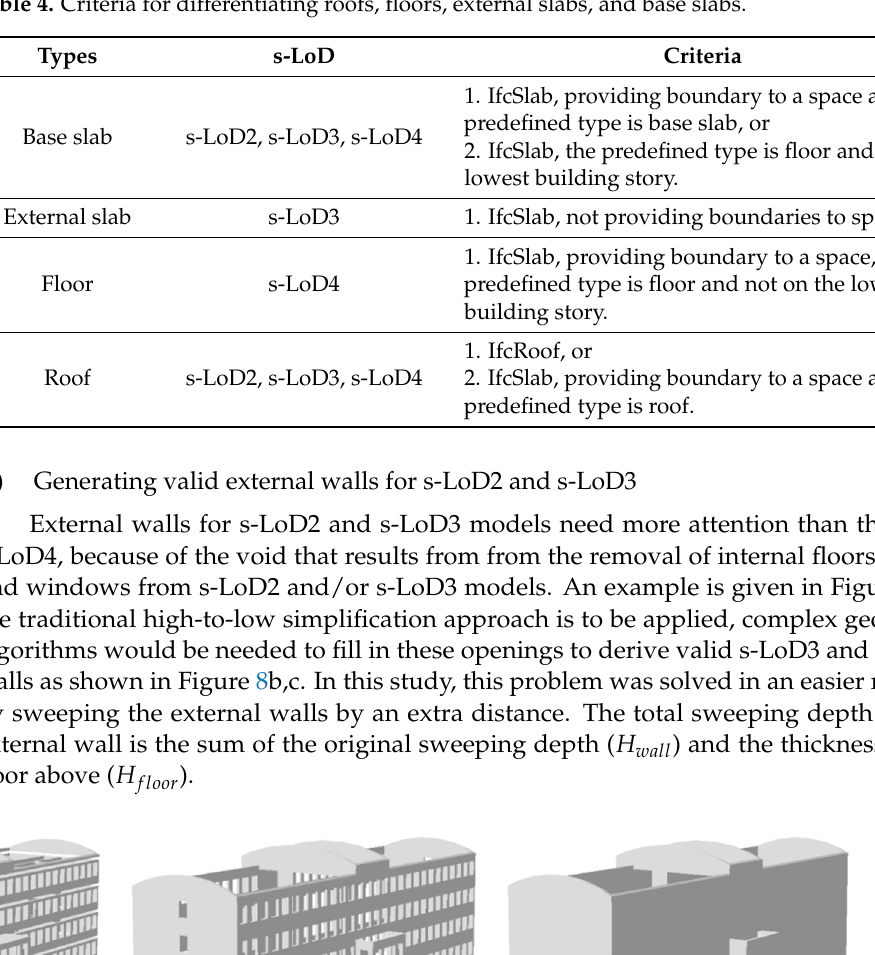
Table 4. Criteria for differentiating roofs, floors, external slabs, and base slabs.